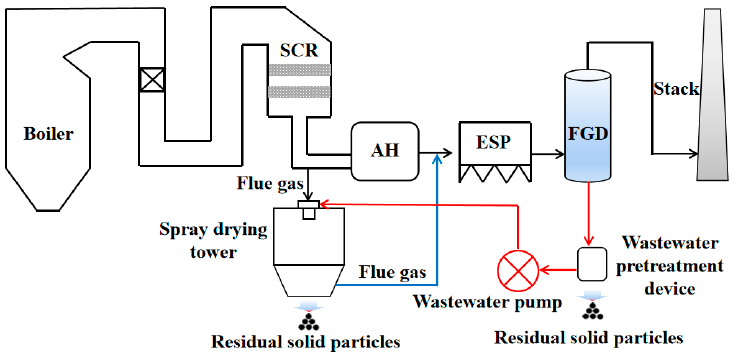
Figure 1. The desulfurization wastewater evaporation technology with flue gas.